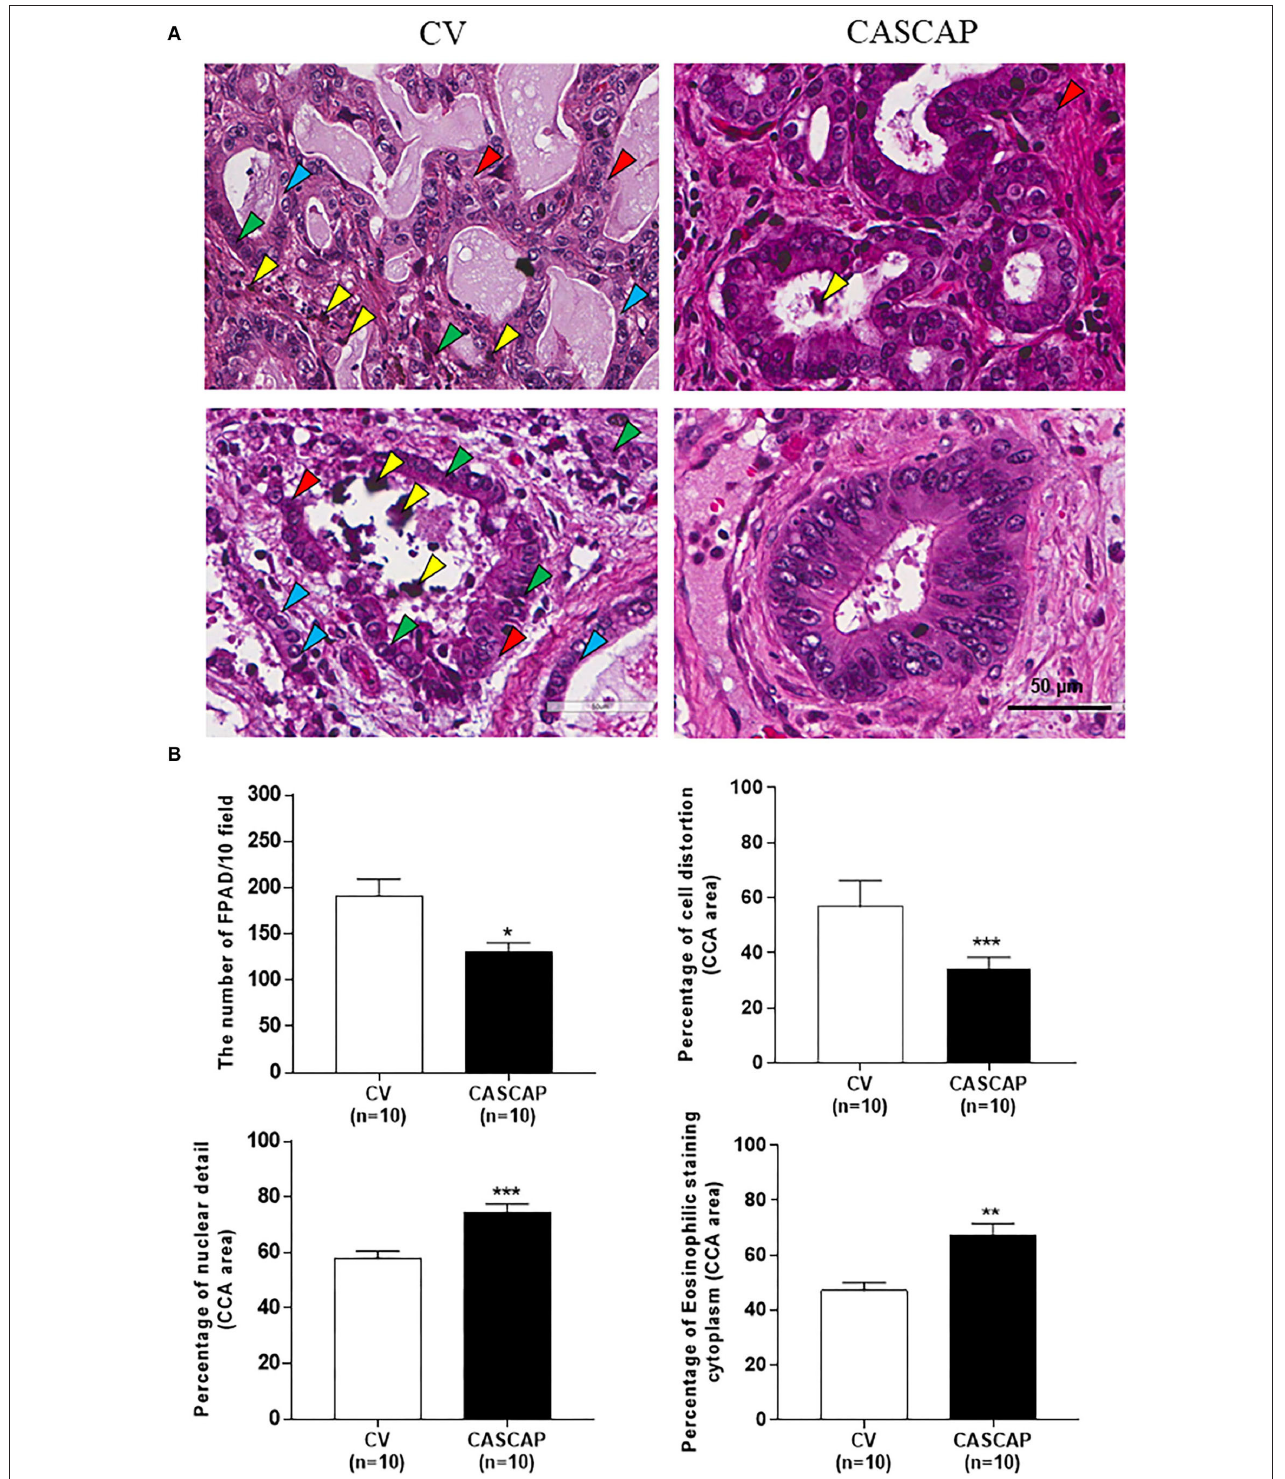
FIGURE 2 | Histopathology of cholangiocarcinoma (CCA) tissues using H&E staining by the two methods, conventional (CV) and new [Cholangiocarcinoma Screening and Care Program (CASCAP)] methods. A comparison of CCA tissue morphologies with staining and structural quality between CV and CASCAP methods. Yellow arrow; formalin pigment artifact deposition (FPAD); Red: cellular structure; green and blue: nuclear and cytoplasm morphologies (A) . The numbers of FPAD in 10 fields/slide and the percentage of each phenotype, such as structural distortion, nuclear details, and eosinophilic staining cytoplasm were determined and shown as mean ± SEM (B) . * p < 0.05, ** p < 0.01, and *** p < 0.001.